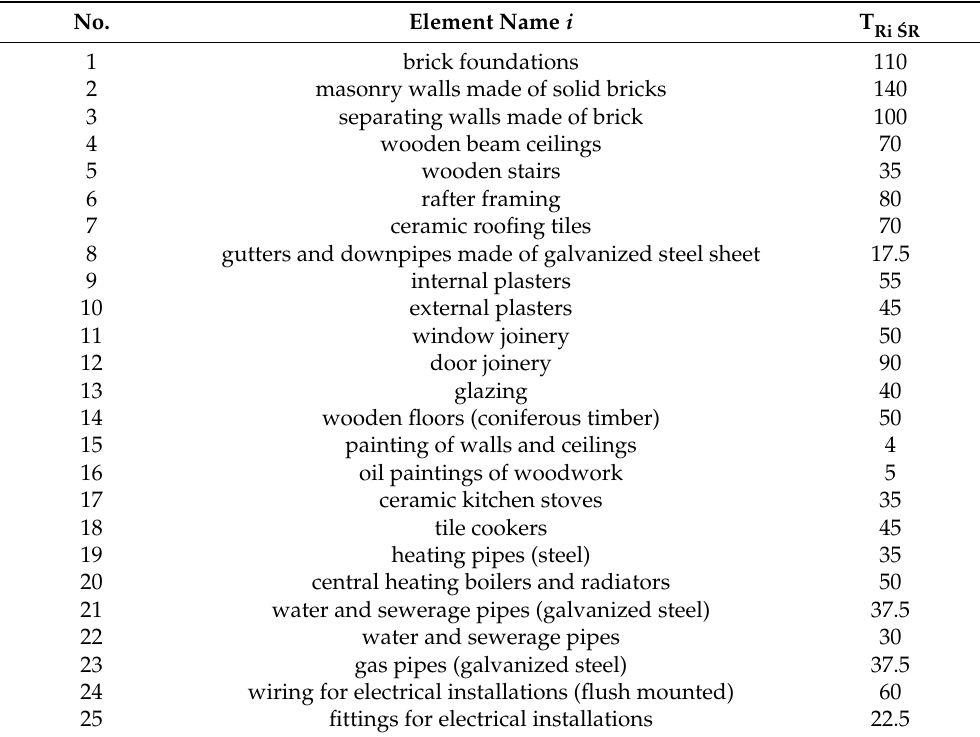
Table 2. Service life of building elements with a specific material and construction system. No. Element Name